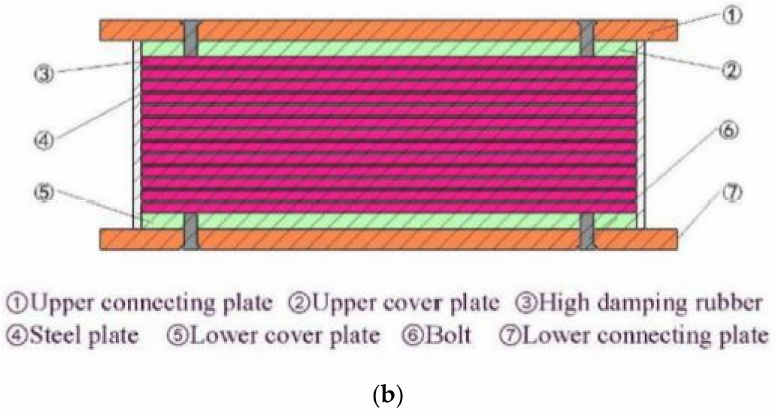
Figure 1. Schematic illustration of the high-damping rubber isolation bearing: ( a ) 1/4 perspective view in 3D and ( b ) Cross-section view